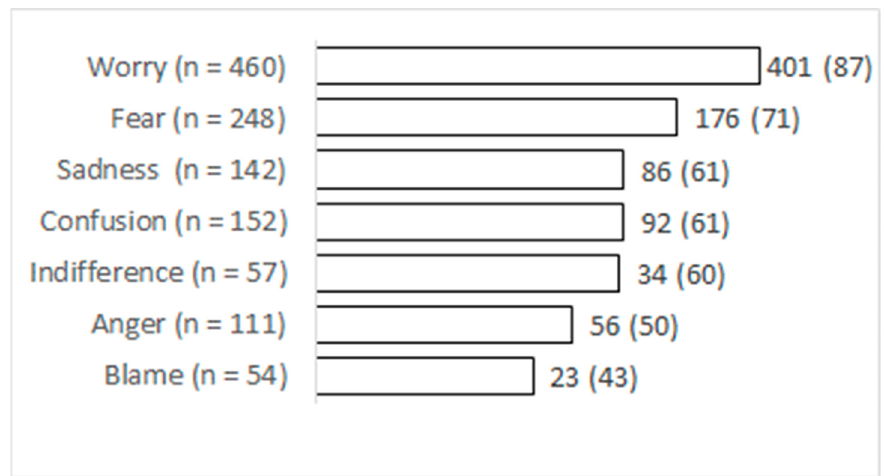
Figure 2. Emotional reactions that persisted from the time of diagnosis and during the acute phase of illness; No (%).